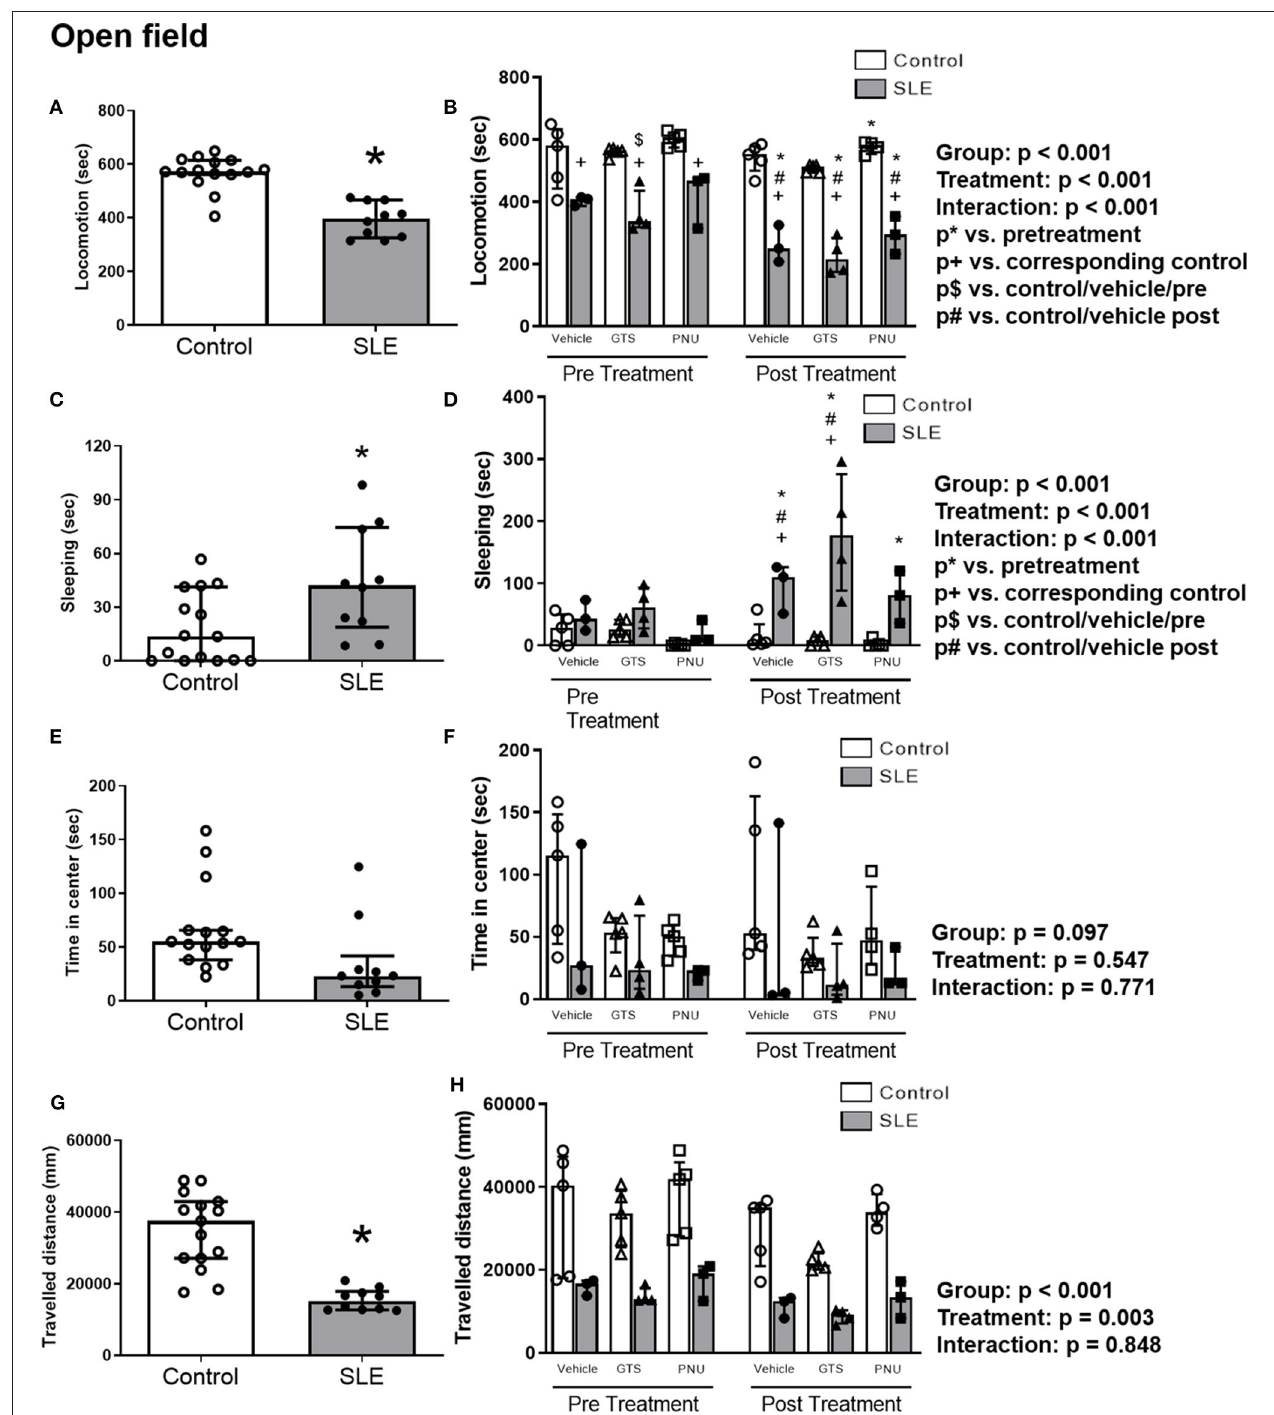
FIGURE 4 | Open field test in control and SLE mice pre-treatment (A,C,E,G) and post-treatment with GTS-21 and PNU-120596 (B,D,F,H) . The pre-treatment data is a comparison between all control and all SLE mice at baseline. A t -test was used to determine significant differences between SLE and control mice pretreatment. SLE mice had lower locomotion (A) , spent a larger amount of time sleeping (C) , and traveled less during the test than controls (G) (all p < 0.05). A two-way ANOVA with repeated measures was used to determine differences between all groups post-treatment ( B,D,F,H ; n = 3–5 per group). The results of each ANOVA appears on the